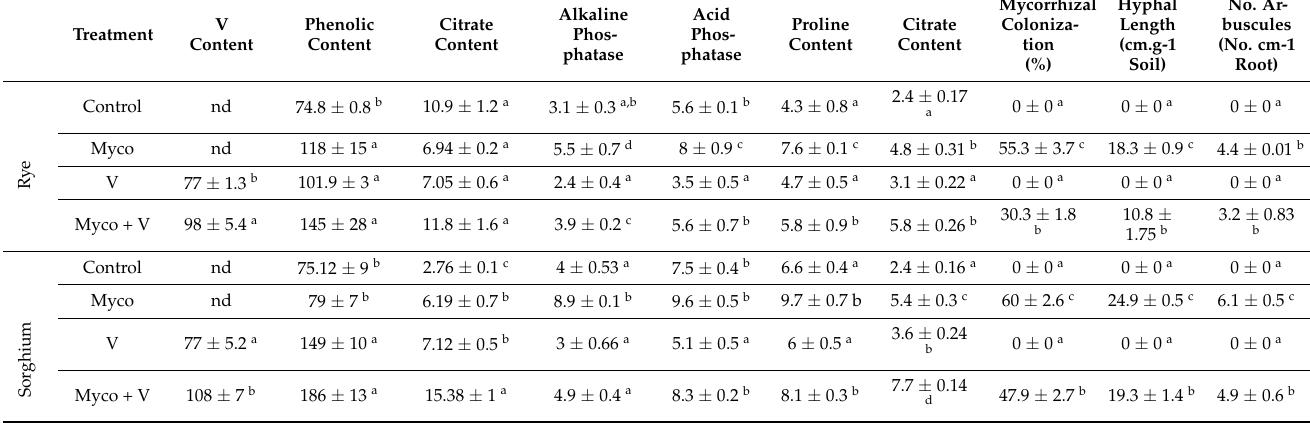
a,b,c,d Different letters indicate statistically significant difference between means of the same plant species at a significance level of at least ( p ≤ 0.05). “nd” means not